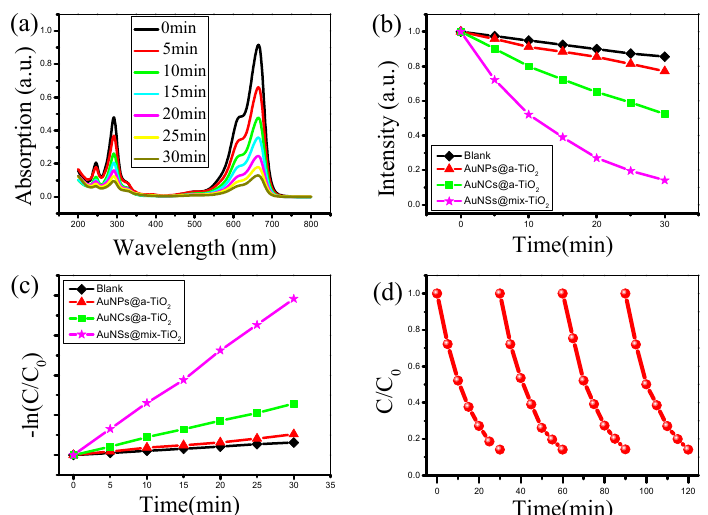
Figure 7. ( a ) Absorption spectrum of methylene blue solution versus 300 W xenon lamp irradiation time; ( b ) The rate of phenol degradation under visible light promoted by various AuNPs@TiO 2 photo ‐ catalysts; ( c ) the corresponding pseudo first ‐ order kinetic rate plot, methyl blue (MB) concentration (C/C 0 ) versus xenon lamp irradiation time; ( d ) photocatalytic stability performance of AuNSs@mix ‐ TiO 2 .